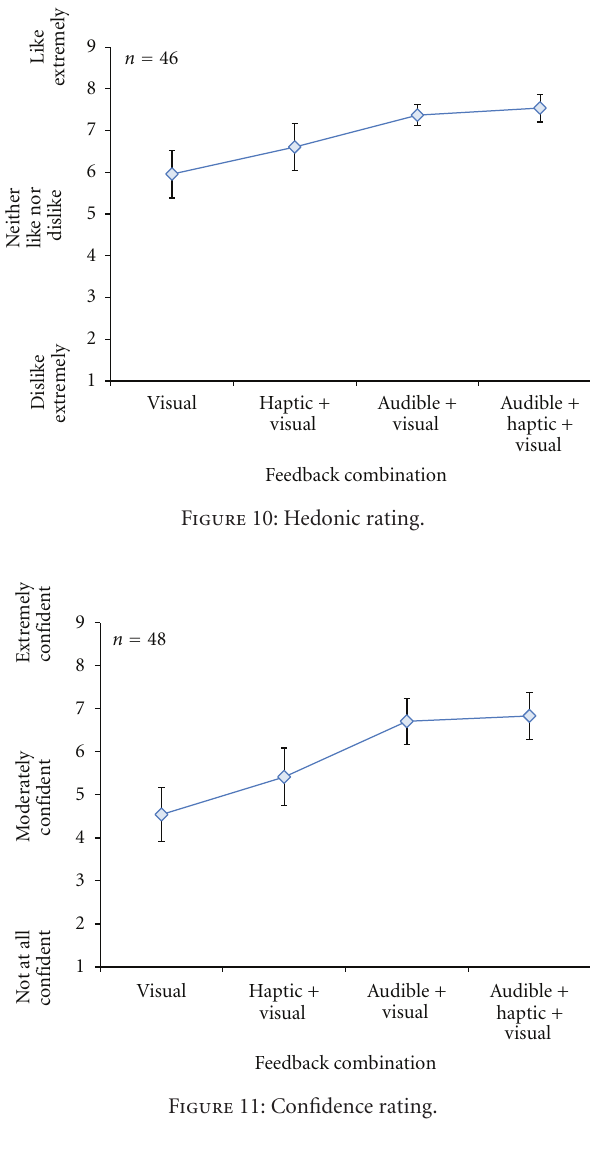
Figure 10: Hedonic rating.